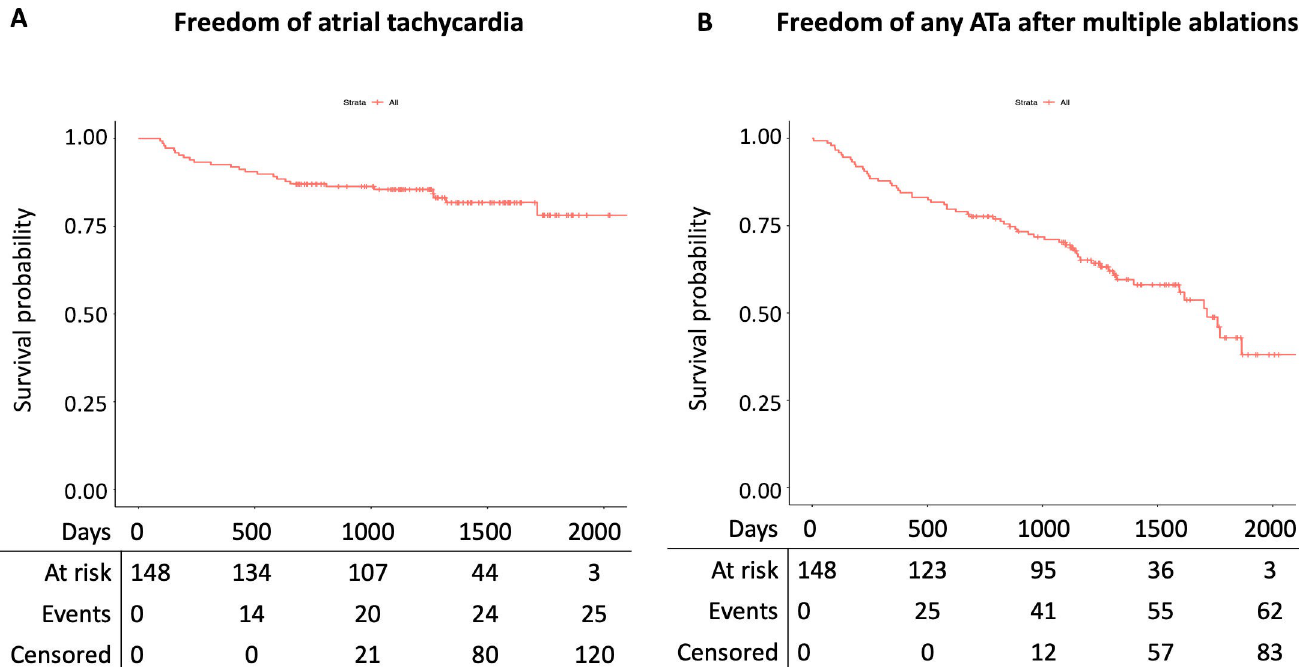
Fig 3. Arrhythmia free survival analyses. A. Survival analysis of freedom of atrial tachycardia. B. Survival analysis of freedom of any atrial arrhythmia after multiple ablations.